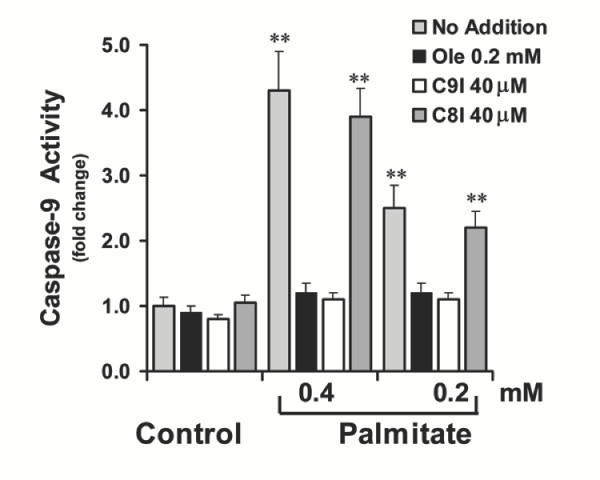
Oleate inhibits caspase 9 activation by palmitate. HMC were treated with palmitate (0.2 and 0.4 mM) or palmitate plus oleate (0.2 mM) for 24 and 48 h. Caspase 9 activity was then measured in HMC extracts adjusted for total protein. In some experiments the cells were treated with palmitate plus selective inhibitors of caspase 9 (C9I) or caspase 8 (C8I) at 40 μM. Data are mean ± SEM for n = 3 experiments in duplicate. **, P < 0.01, *, P < 0.05 versus control or palmitate plus oleate by ANOVA.